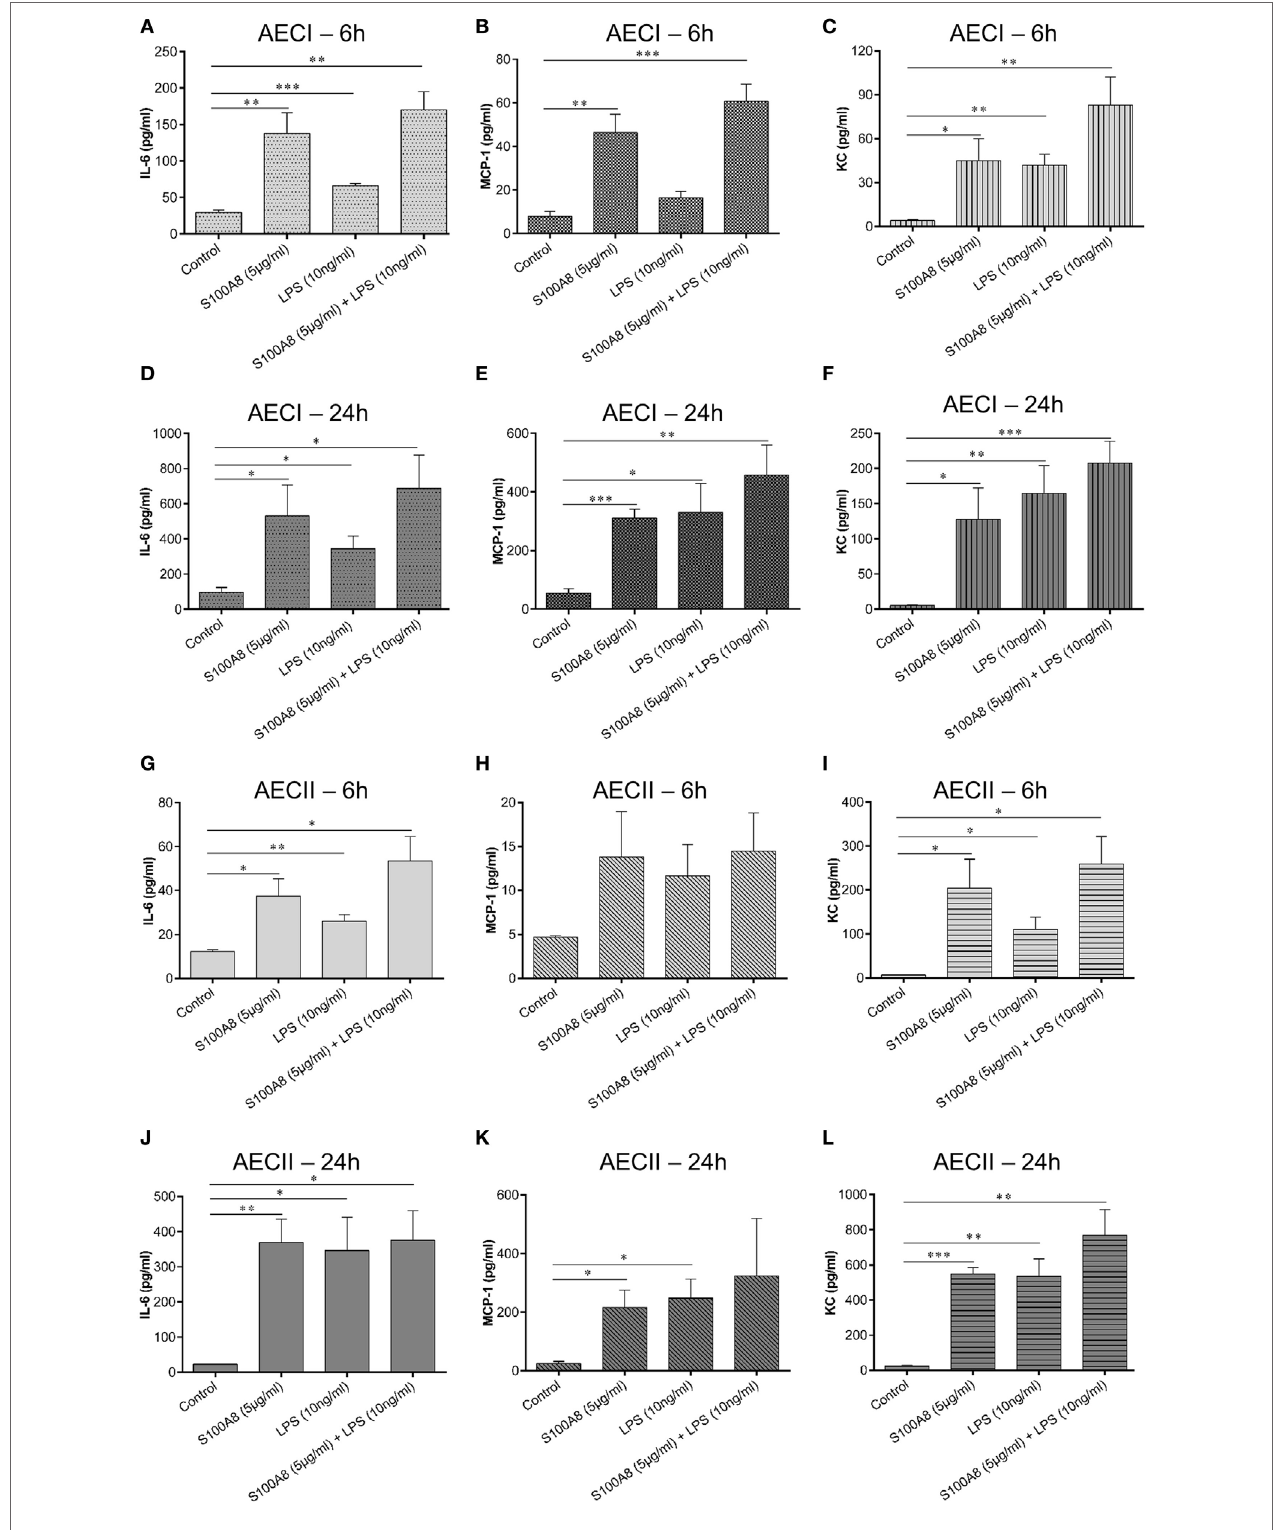
FigUre 3 | S100A8 and lipopolysaccharide (LPS)-induced production of various cytokines/chemokines from alveolar epithelial cells (AECs). Murine S100A8 (5 µg ml − 1 ) or LPS (10 ng ml − 1 ) or a combination of both were used to stimulate confluent monolayers of AECI (a–F) or AECII (g–l) . (a,D,g,J) IL-6, (B,e,h,K) MCP-1, and (c,F,i,l) KC were measured after 6 and 24 h of stimulation. Data are expressed as mean ± SEM [ n = 4 experiments for AECI (a–F) , n = 3 experiments for AECII (g–l) ]. * p < 0.05, ** p < 0.01, *** p < 0.001 compared to respective unstimulated cells